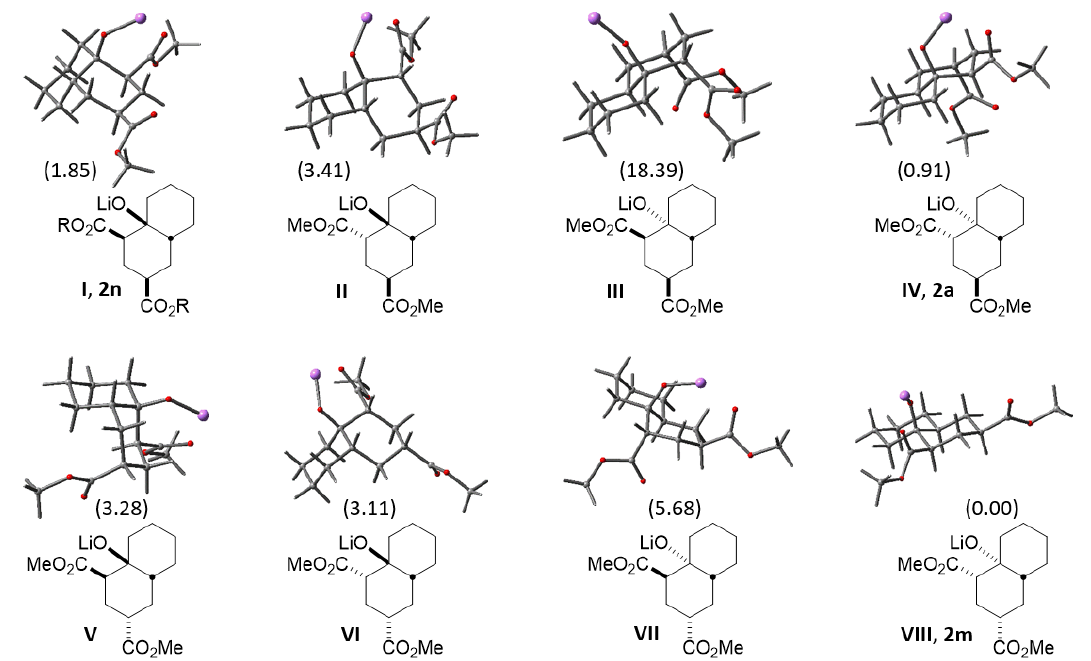
Figure 4. Plain and optimized 3D structures of the eight possible diastereomers ( I – VIII ) obtained by MIMIRC reaction between cyclohexanone lithium enolate and methyl acrylate. These projections show the most stable conformer for each diastereomer and its relative energies in brackets. Diastere- omers 2n (R = Et), 2a and 2m correspond to the protonated version of compounds I , IV and VIII , respectively. The energy shown for 2n is for the dimethyl ester (R = Me).